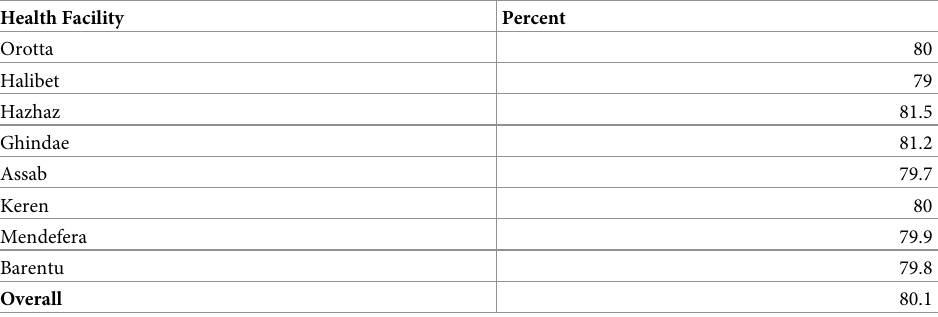
Table 6. Percentage distribution on availability of key essential